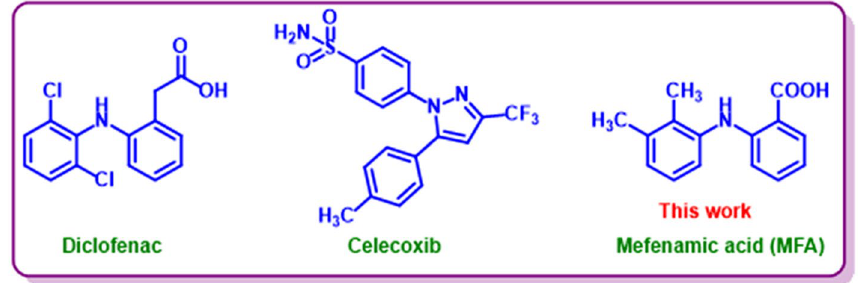
Figure 1. The structure of ( A ) Diclofenac, ( B ) Celecoxib, and ( C ) Mefenamic acid ( MFA ) as NSAIDs containing aromatic